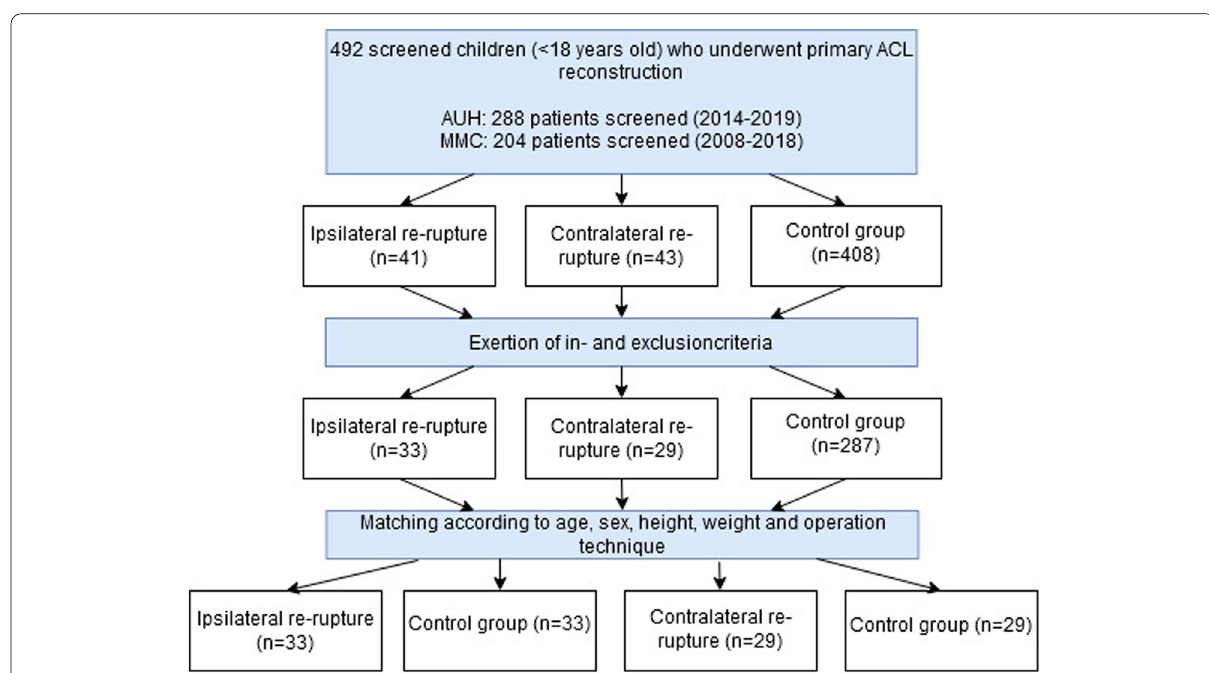
Aarhus University Hospital”, “MMC =